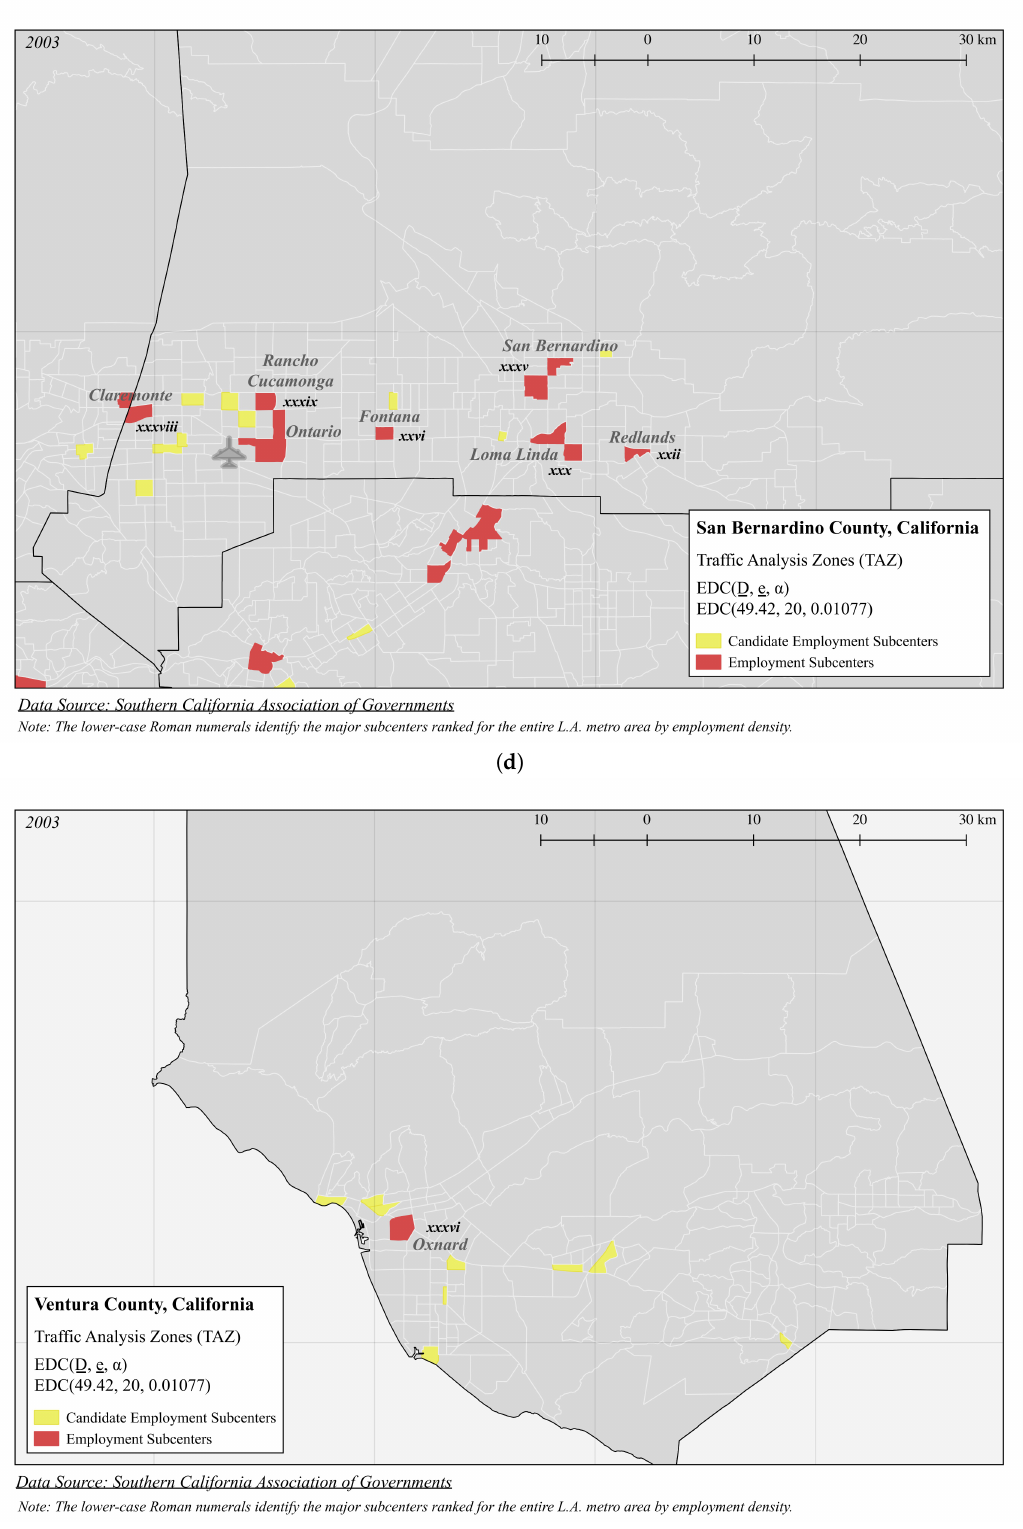
Figure A1. Los Angeles metropolitan area subcenters by county identified by EDC(49.42, 20, 0.01077): ( a ) Los Angeles County; ( b ) Orange County; ( c ) Riverside County; ( d ) San Bernardino County; ( e ) Ventura